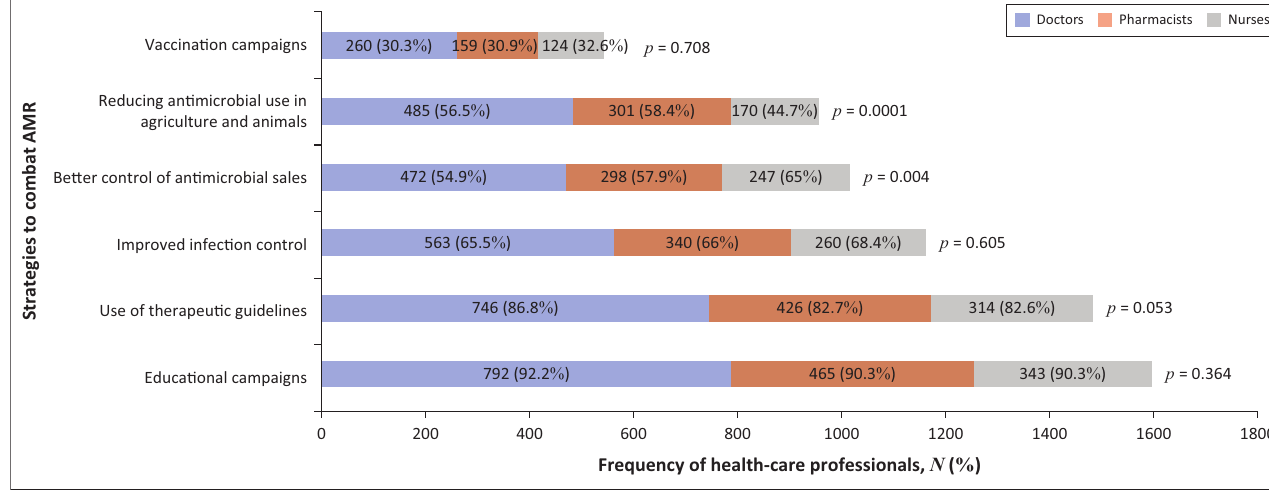
FIG URE 3: Attitudes on strategies that would combat antimicrobial